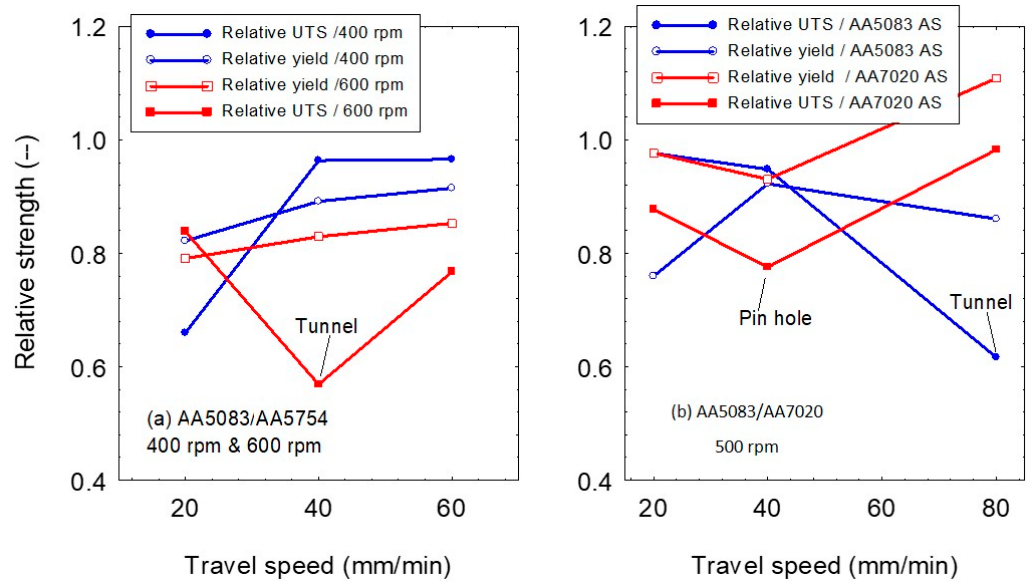
Figure 11. Relative tensile strength ( σ UTS joint/ σ UTS 5083) and relative yield stress ( σ 0.2% joint/ σ 0.2% 5083) of the produced FSW joints against the welding speeds.